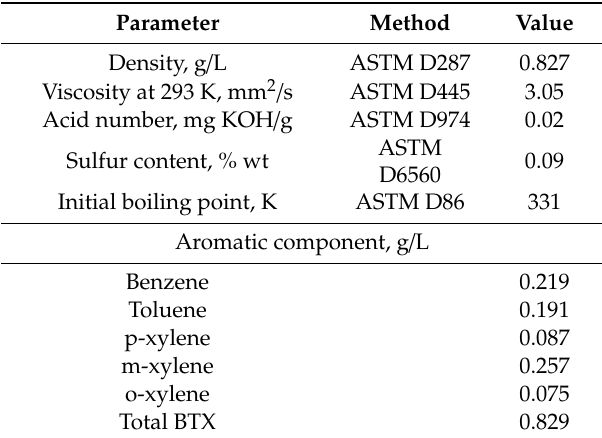
Table 1. Basic properties of crude